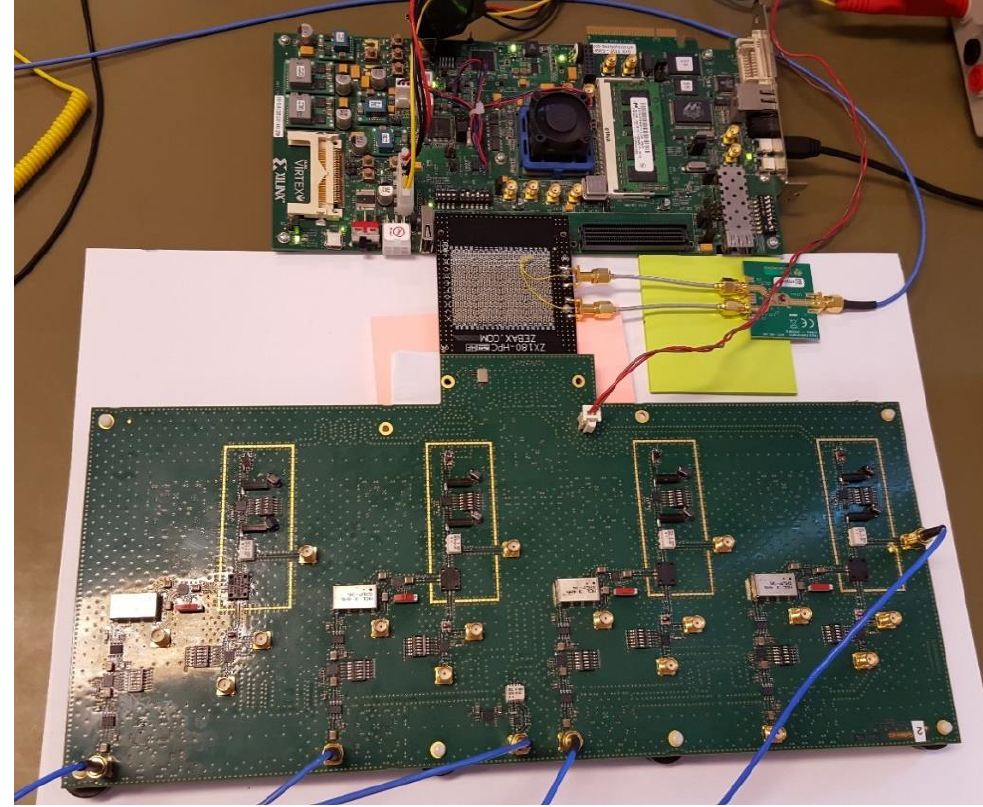
Figure 5. Photo of compressed sampling prototype analog board ( bottom ) and the ML605 board ( top